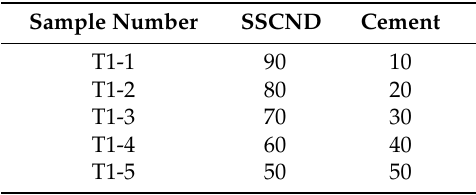
Table 2. Proportion of SSCND and cement used for the preparation of gellable composite materials (GCM) (wt